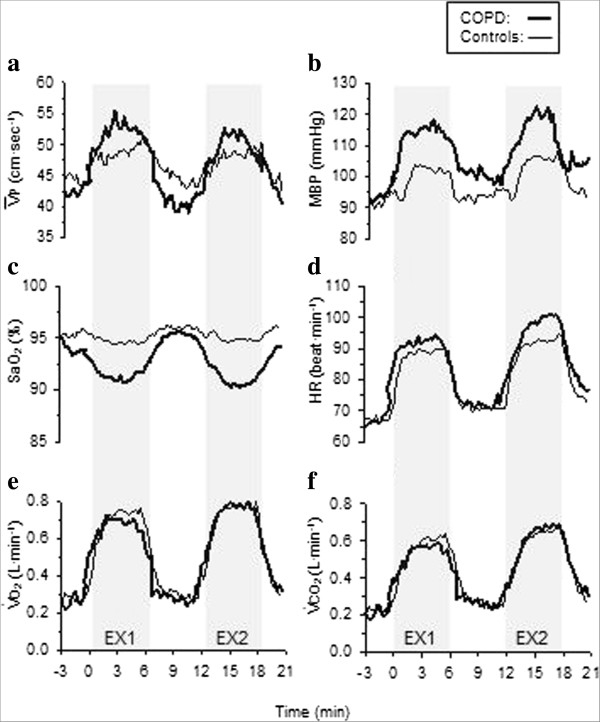
Continuous representation of the physiological responses to two, 6-minute exercise periods in women with moderate COPD (thick line) and healthy age-matched controls (thin line). Exercise 1 (EX1; 50% V˙O2peak) and Exercise 2 (EX2; 30 Watts) were separated by 6-minutes of resting recovery. a) Peak cerebral blood flow velocity in the middle cerebral artery (V¯P); b) mean arterial blood pressure (MBP); c) arterial oxygen saturation (Sao2); d) heart rate (HR); e) volume of oxygen consumption (V˙O2); and f) volume of carbon dioxide production (V˙CO2). Data represent 15-second averages. Cycling exercise periods are shaded.